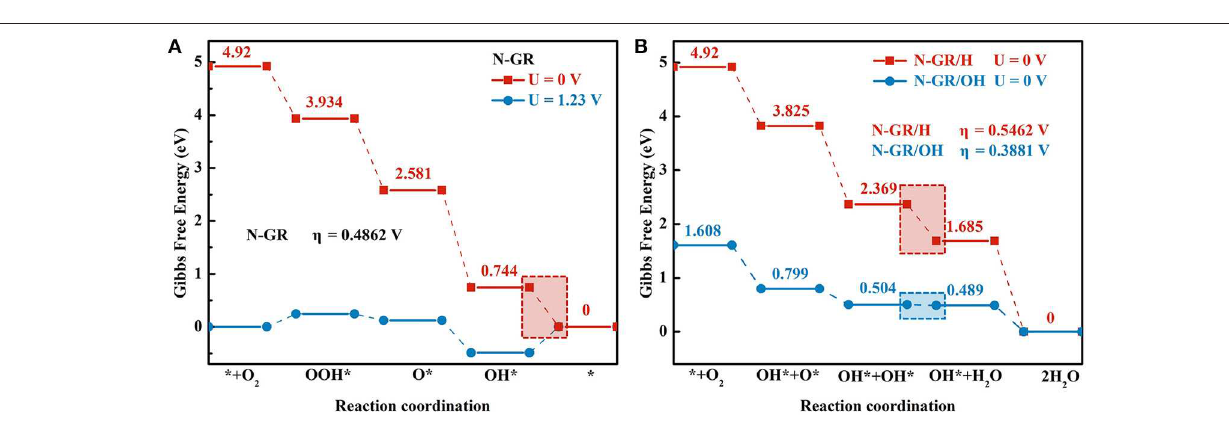
FIGURE 4 | The reaction Gibbs free energy diagrams of four elementary reaction steps of ORR on (A) N-GR and (B) N-GR/H and N-GR/OH. The shadow box highlights the rate-determining step.